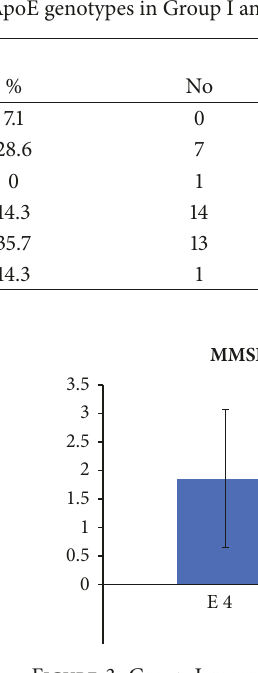
Figure 3: Group I mean MMSE change in ApoE 𝜀 4 carrier/non-